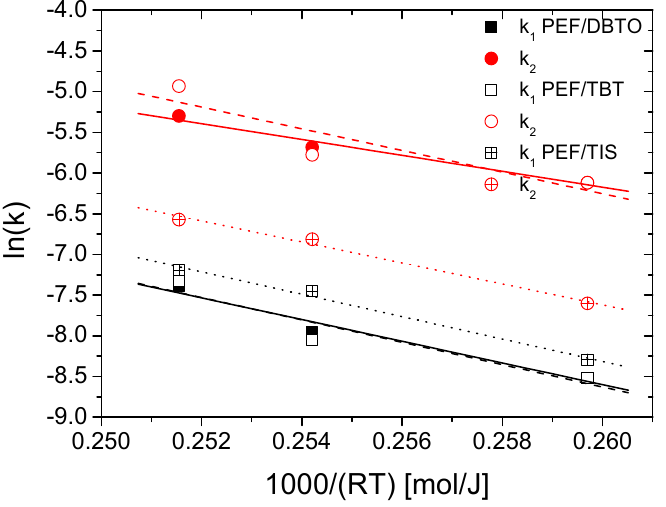
Figure 5. Arrhenius type plots to estimate the activation energy of the polycondensation and esterification reactions for PEF prepared by different catalysts. esterification reactions for PEF prepared by different